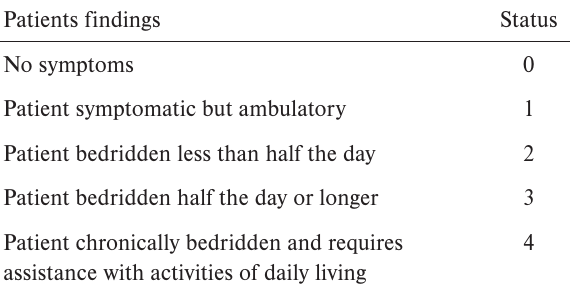
Table 1. Performance